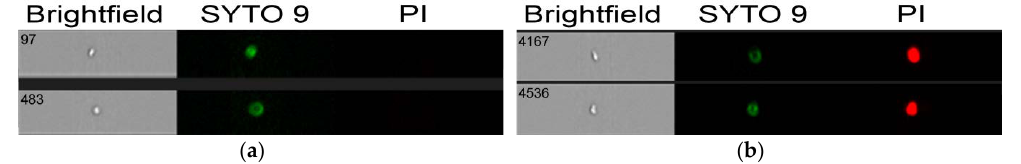
Figure 3. Image gallery of both: ( a ) live, labelled green; ( b ) dead, labelled red and less green cells of E. faecalis.